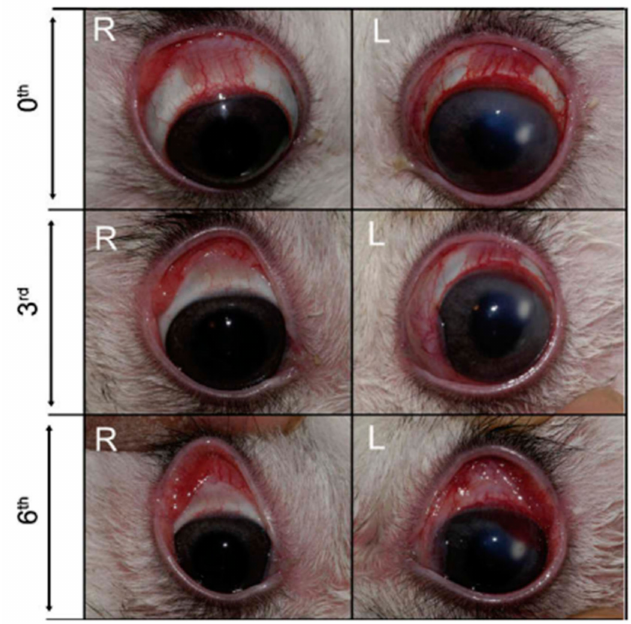
Figure 7. Rabbits’ eyes infected with S. aureus after 3- and 6-days treatment with bioadhesive sulfacetamide-loaded polycarbophil microspheres (right eyes, R) and sulfacetamide alone (left eyes, L). Reproduced from Sensoy et al.